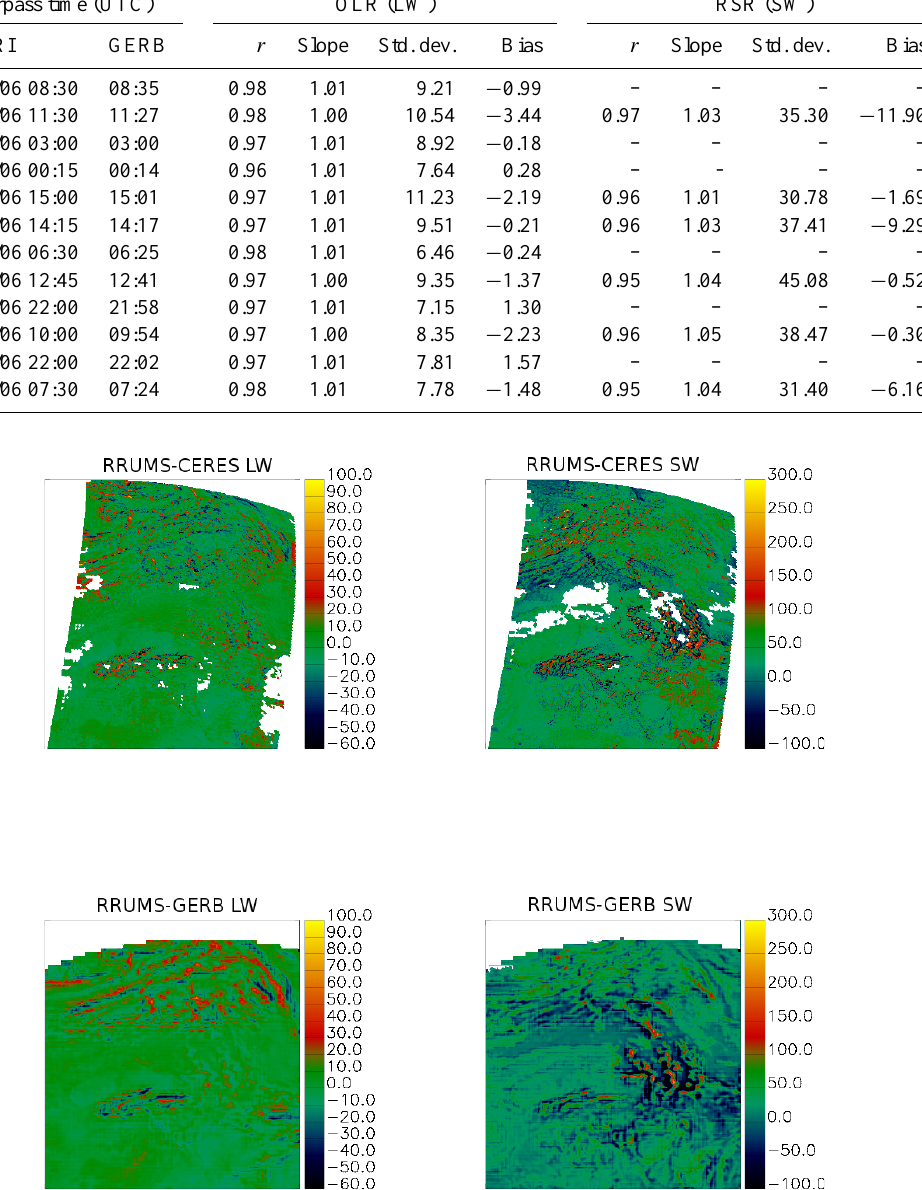
Table 4. Comparison between SEVIRI-based RRUMS retrieval and GERB measurements. Bias and standard deviation in Wm − 2 . Overpass time (UTC)